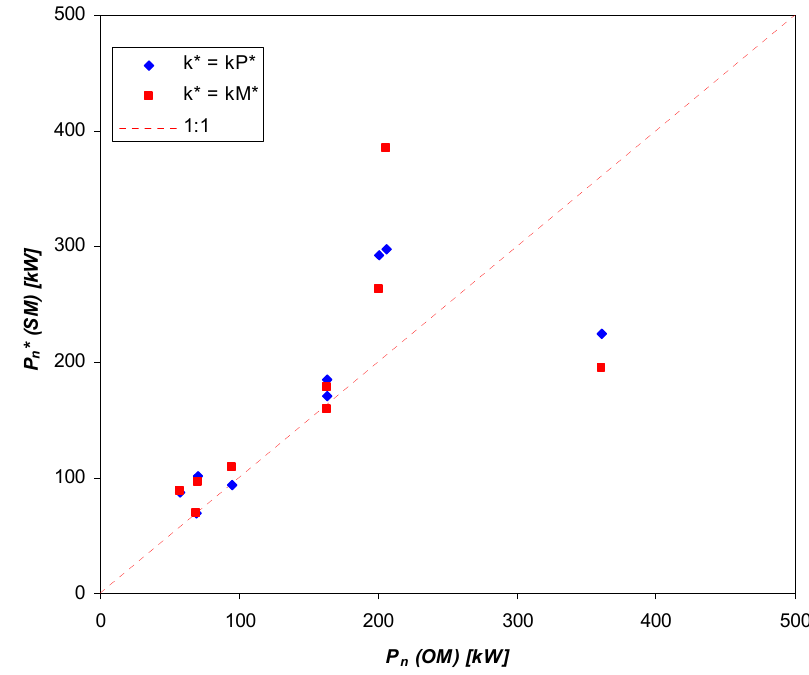
Figure 5. Comparison of the net electrical power ( P n ) estimated by the original (OM) and simplified (SM) methods ( P n ** for k* = k P and k M ) for evaluating SHP energy production in seven irrigation systems of Calabria (Southern Italy).